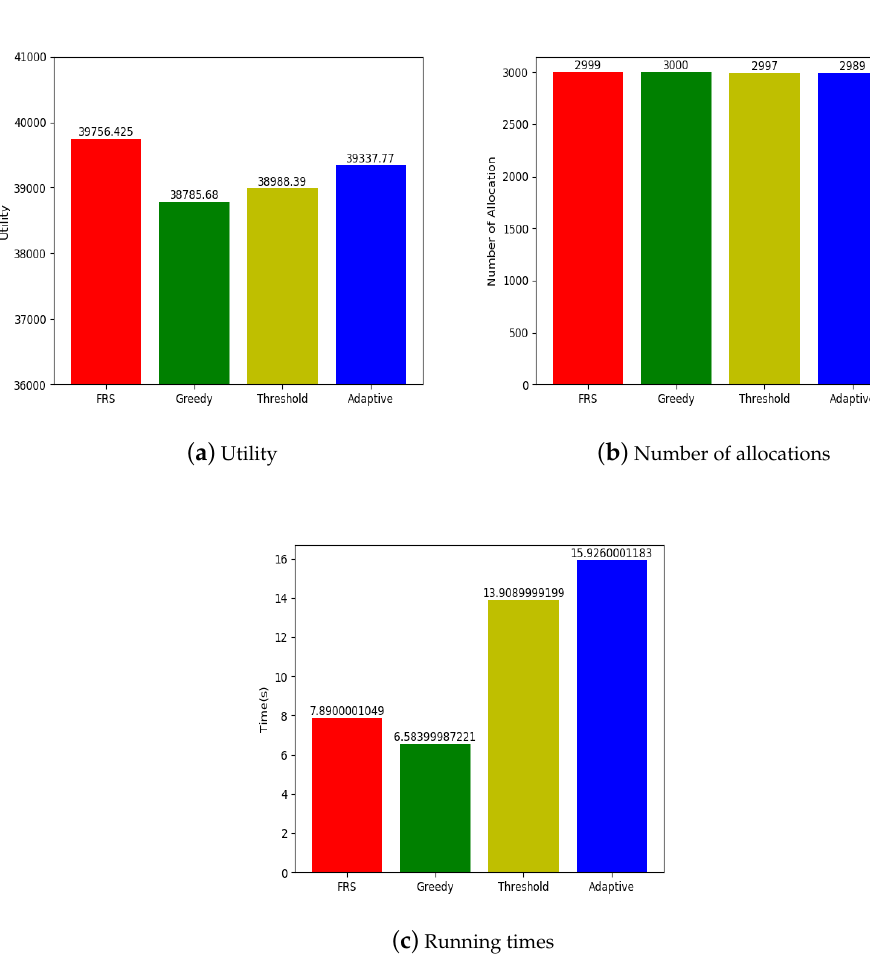
Figure 10. Comparison result of Yelp